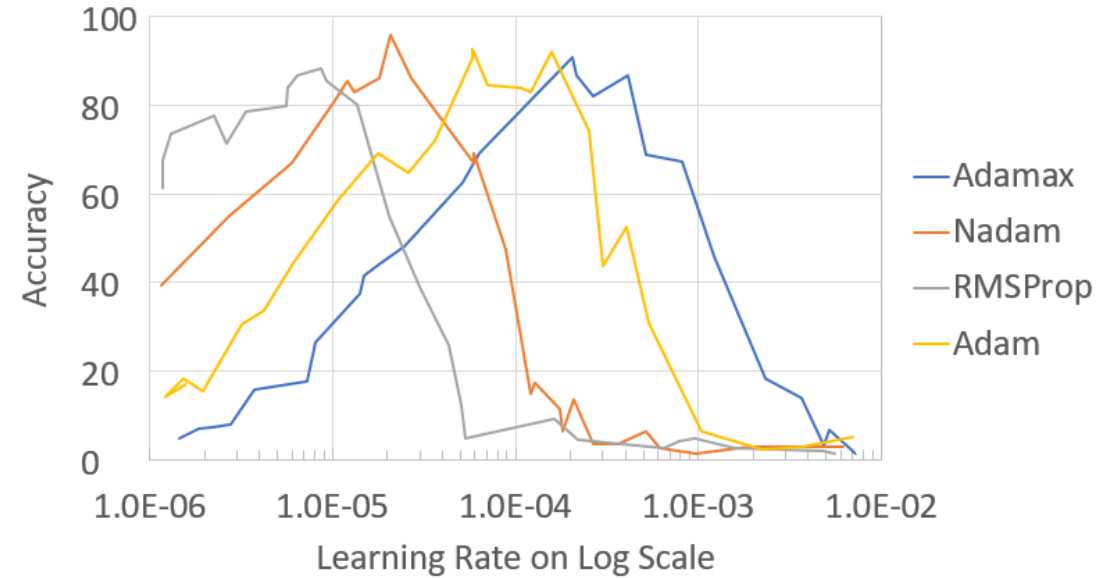
Figure 7. Optimizer accuracy to learning rate comparison using TB5 free-space data set and ResNeXt 50 architecture. Accuracies are recorded after 5 epochs of training for learning rates selected by the Hyperopt algorithm.